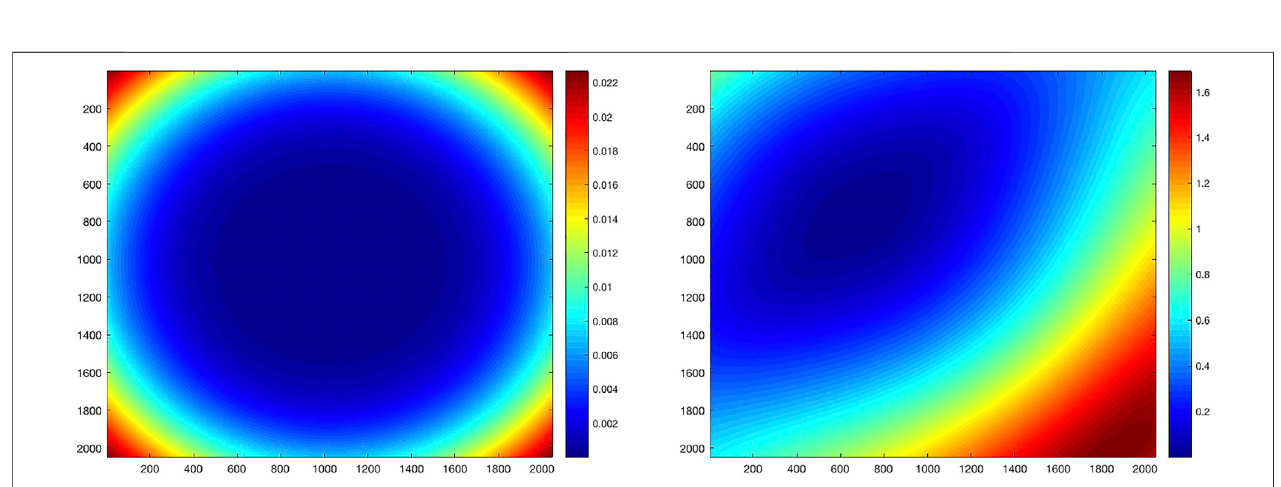
FIGURE 10 | Left: Optical distortion solution, radial component only. Right: Optical distortion solution, radial and tangential components. The color indicates magnitude of offset due to distortion in pixels.